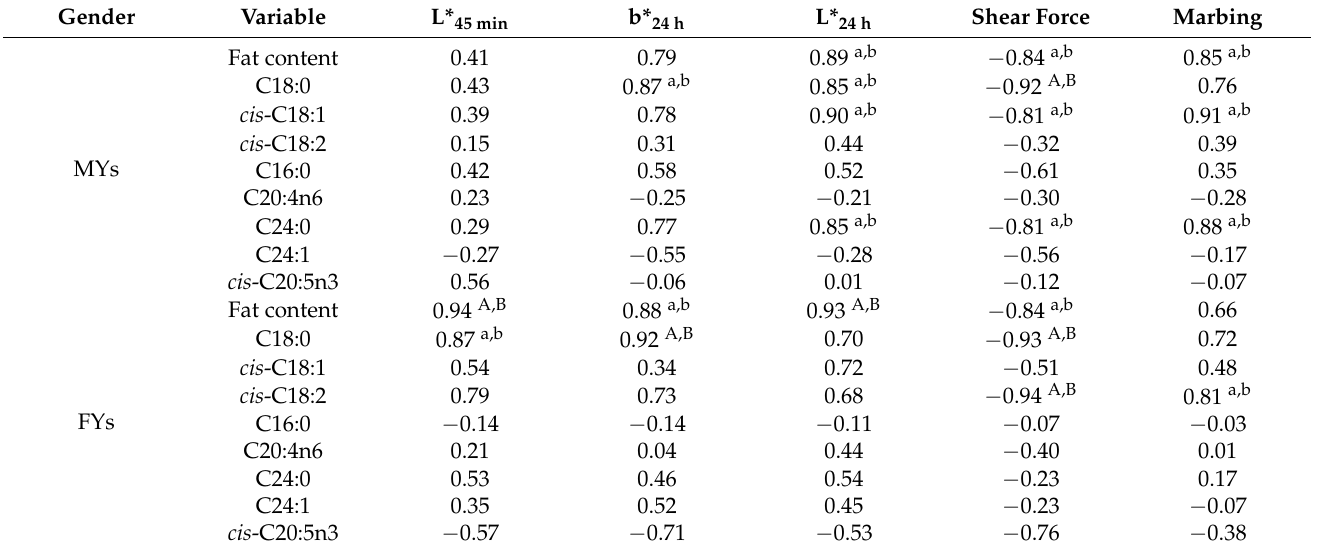
Table 5. The Pearson correlation analysis between meat quality and FAs, fat content (absolute content) in LD of FYs and MYs.